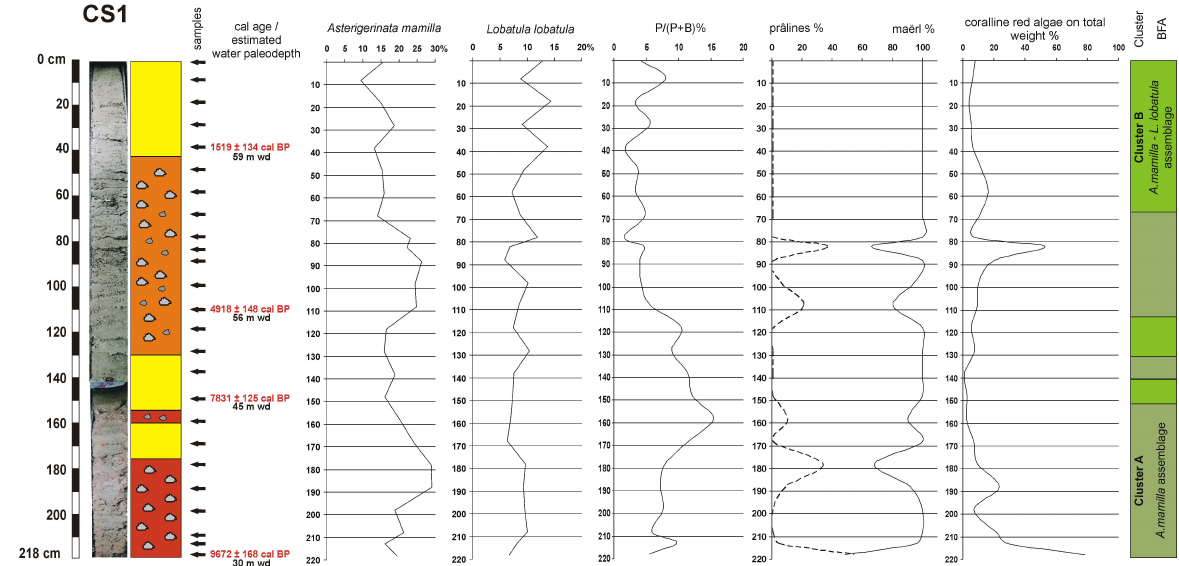
Figure 7. Summary of main data of core CS1: lithology; calibrated radiocarbon dating (yr BP); estimated water paleodepth (according to the sea-level rise curve of [66]); distribution of must abundant benthic foraminiferal species along the core ( Asterigerinata mamilla and Lobatula lobatula ); P/(P + B)%; pr â lines and maërl abundances; percentage of coralline red algae on total weight; distribution of clusters recognized from Q-mode HCA (cluster A: dark green; cluster B: light green) and relative benthic foraminiferal assemblages